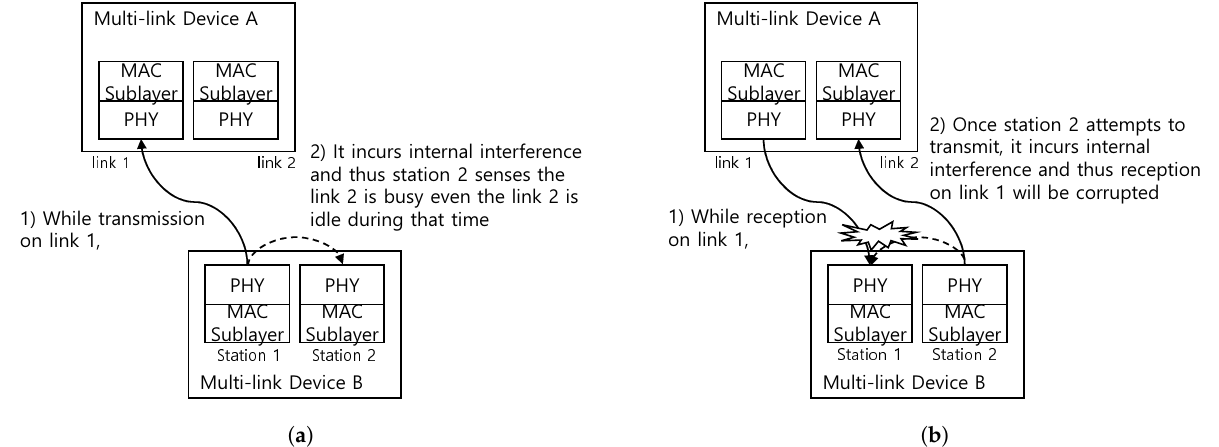
Figure 2. Considerations on designing multi-link distributed coordination function (DCF) for non-simultaneously transmit and receive (STR) case. ( a ) Transmission hindrance due to in-device interference and ( b ) reception hindrance due to in-device